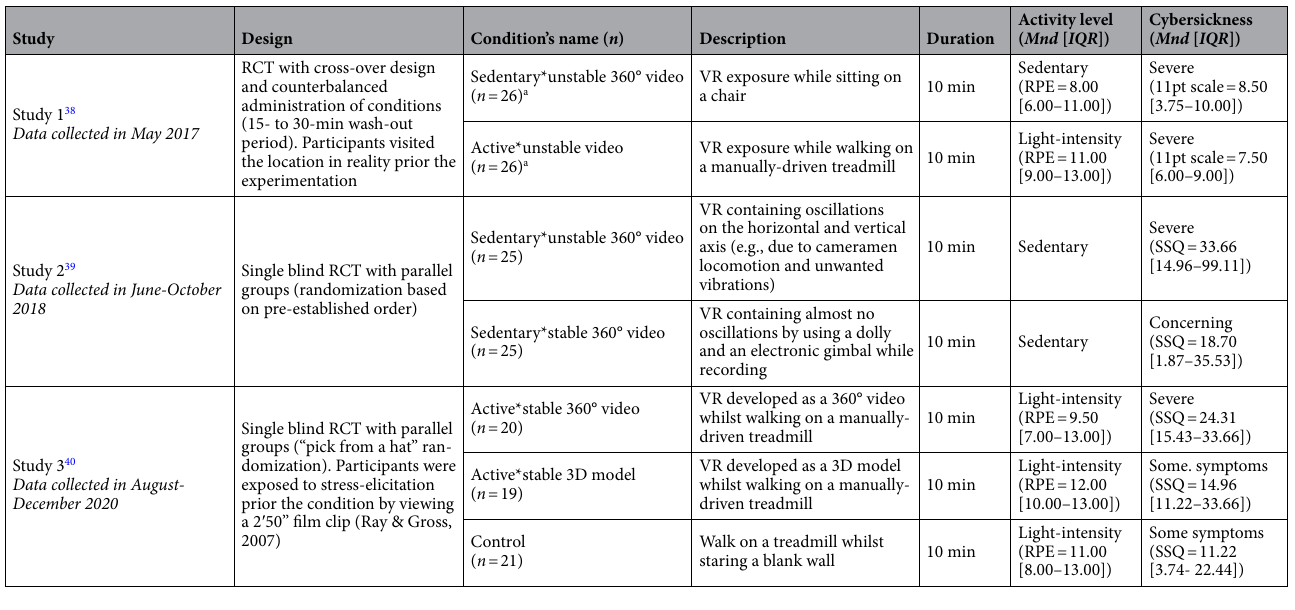
Table 1. Overview of experimental conditions in the different studies. RPE = Ratings of perceived exertion (6 = “Rest”, 9 = “Very light”, 13 = “Somewhat hard”). 11pt scale = Single item “I got dizzy during the virtual walk”, 11-point Likerst scale (0 = Not at all; 5 = Neutral; 10 = Absolutely). SSQ = Simulator-Sickness Questionnaire (10–15 = Some symptoms; 15–20 = Concerning, > 20 = Severe [Kennedy et al., 2003]). NB: the SQQ